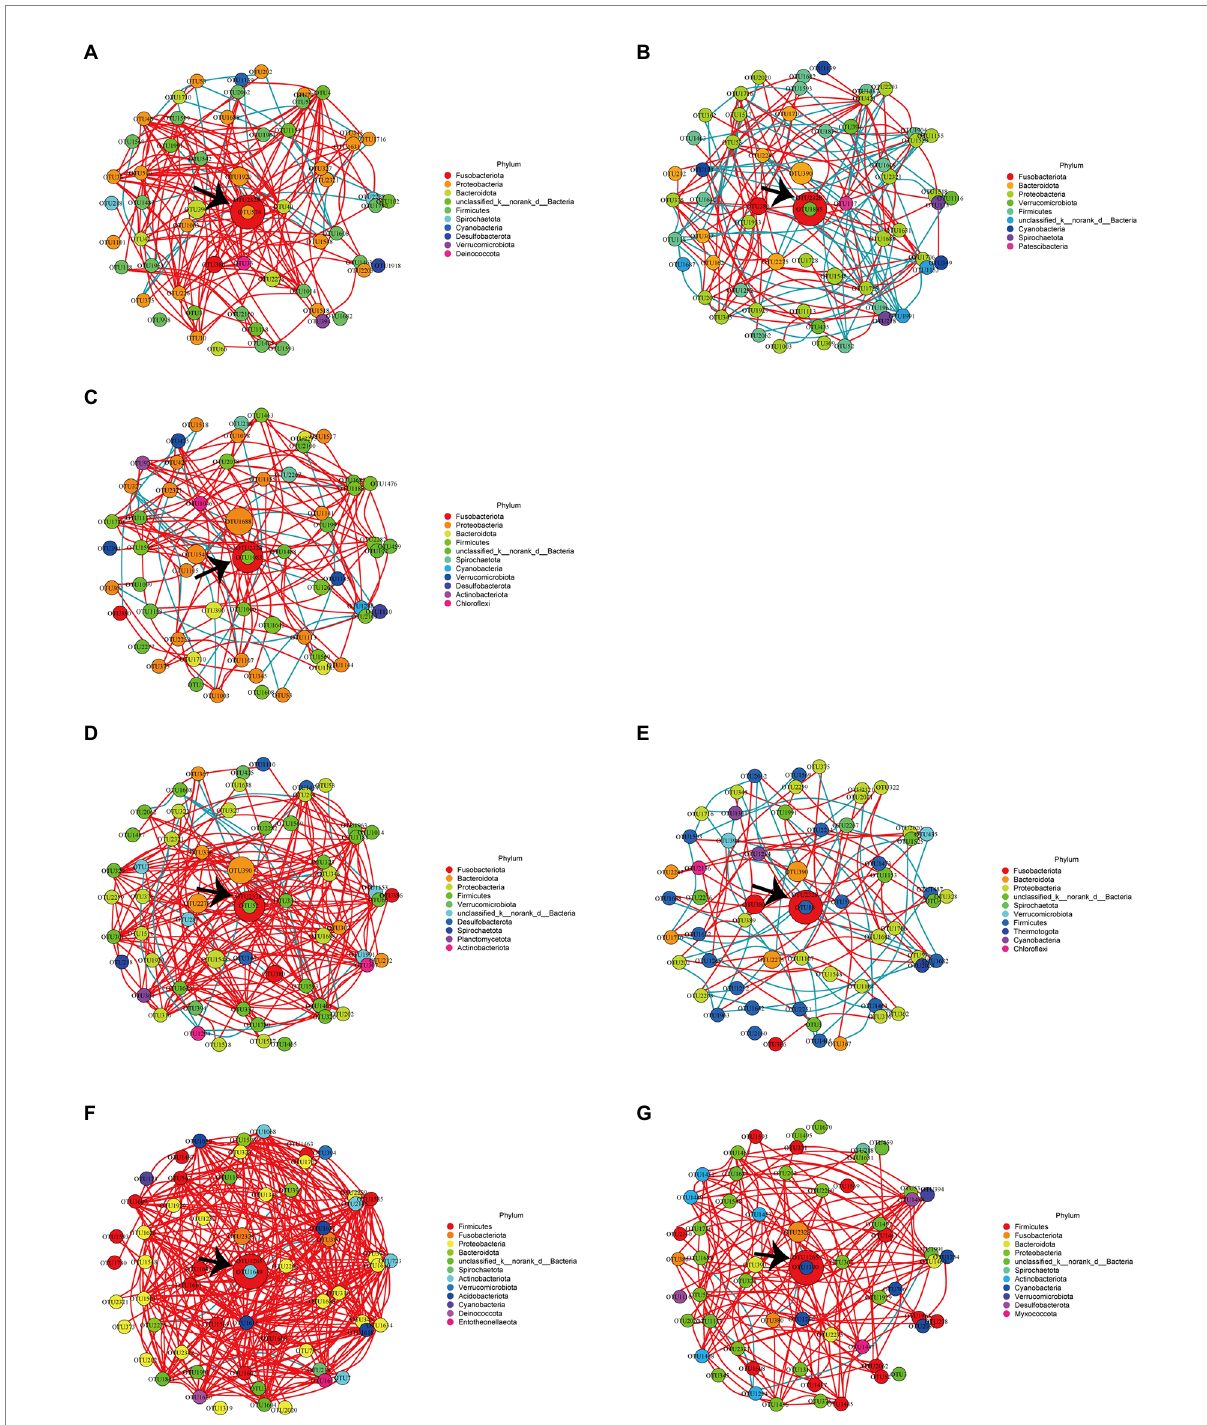
FIGURE 4 Network analysis of the 60 most abundant OTUs with an absolute Spearman correlation coefficient greater than 0.8 within the (A) CTRL21 group, (B) FKV21 group, (C) ∆ Sia21 group, (D) CTRL35 group, (E) FKV35 group, (F) ∆ Sia35H group, and (G) ∆ Sia35L group. Each node represents an OTU; the node’s size reflects abundance, and the node’s color corresponds to a phylum. Red edges indicate positive correlations, whereas blue edges indicate negative correlations. The most abundant OTU in each group is indicated by black arrows. CTRL21, control group at 21 dpiv; FKV21, FKV group at 21 dpiv; ∆ Sia21, LAV ∆ Sia group at 21 dpiv. CTRL35, control group at 35 dpiv; FKV35, FKV vaccine group at 35 dpiv (14 days after the second immunization); ∆ Sia35H, LAV ∆ Sia group with a high serum antibody response at 35 dpiv (14 days after the second immunization); ∆ Sia35L, LAV ∆ Sia group with a low serum antibody response at 35